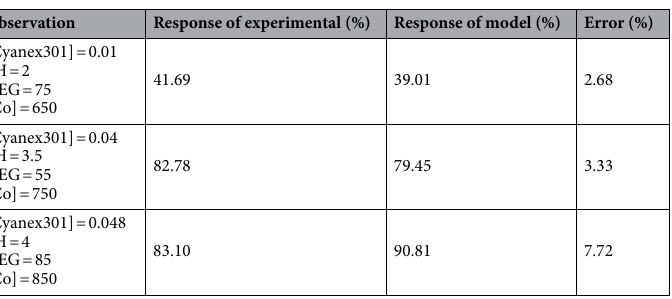
Table 4. Comparison of the correlation of the predicted results with the experimental